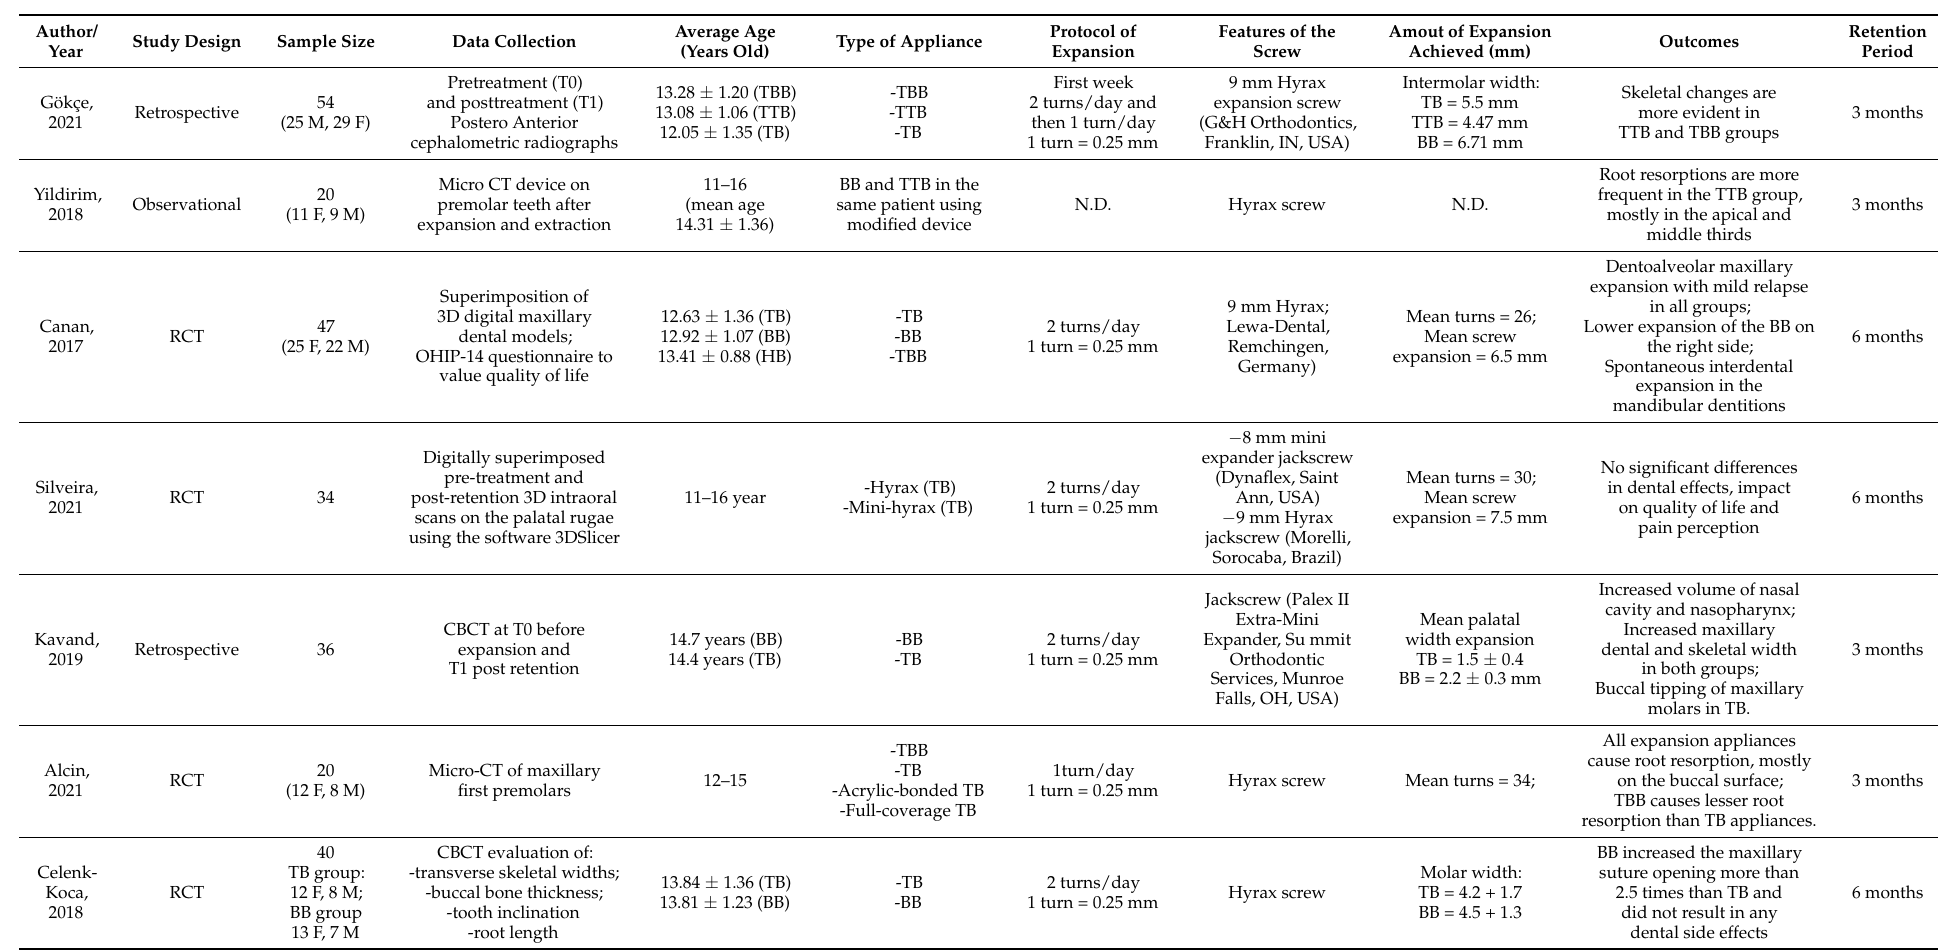
Table 1. Summary of selected articles